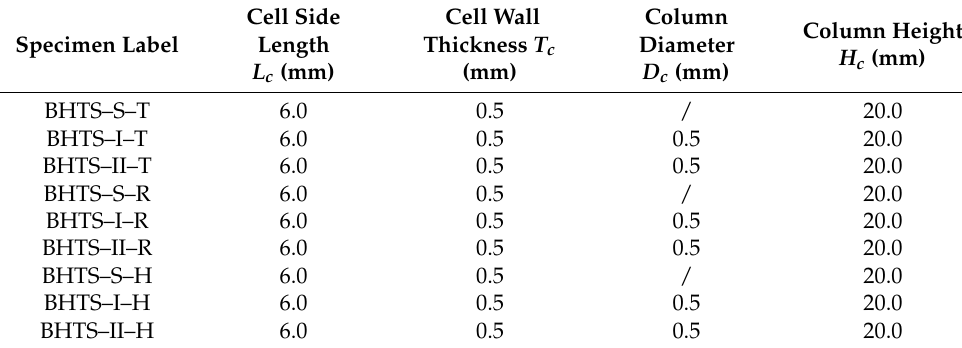
Figure 3. BHTS models. Table 1. BHTS parameters of the study.